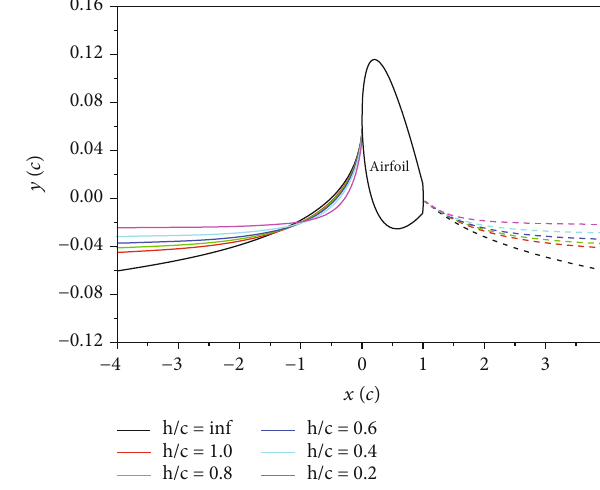
Figure 22: Pressure coe ffi cient of the CC airfoil without blowing at α = 4 ° .